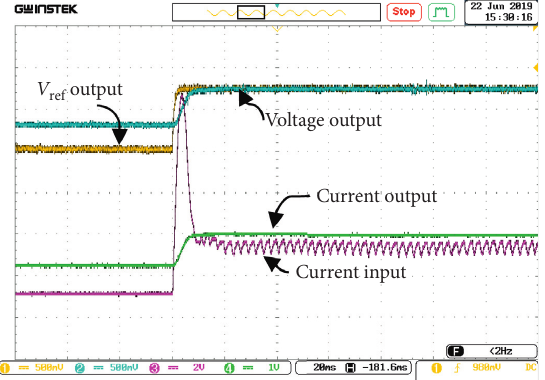
Figure 23: Result of voltage response and current using a PI controller with PSO search.